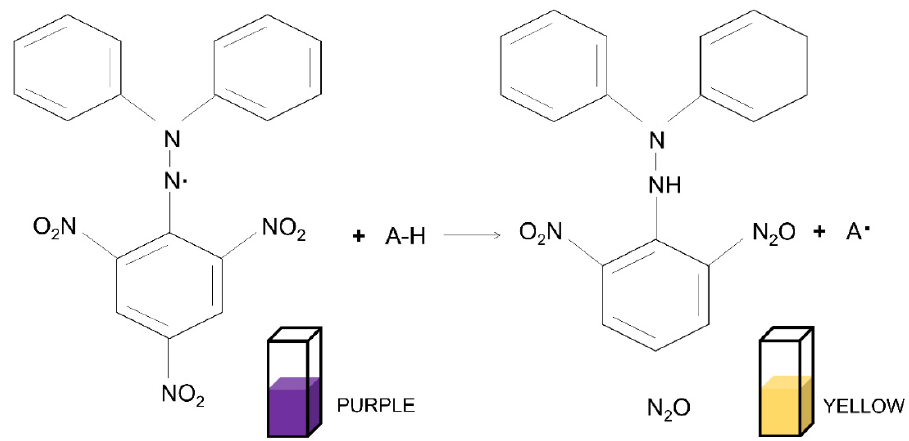
Figure 6. The reaction of DPPH assay when the antioxidant agent is present. The image is